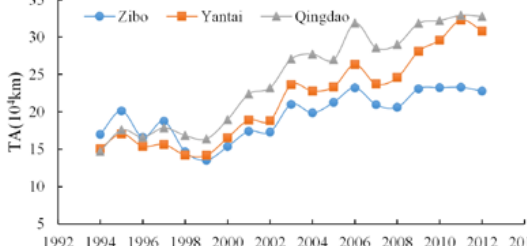
Figure 10. The variation of TA metric of Zibo, Yantai and